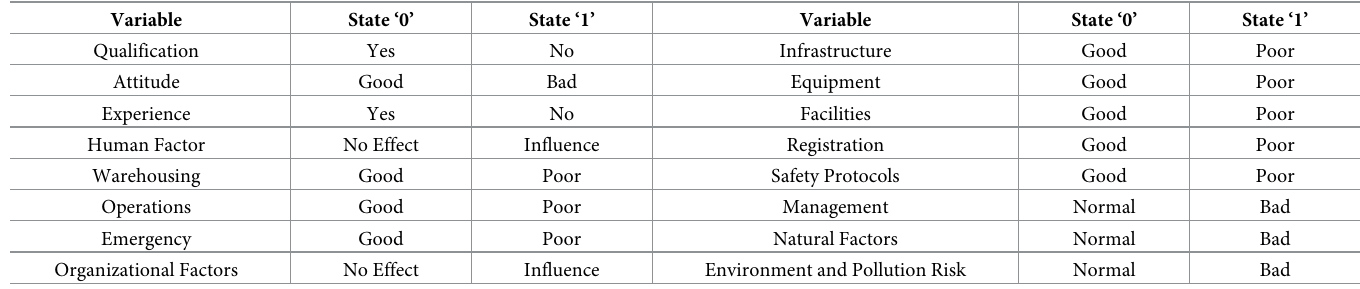
Table 1. Depiction of the variables considered for this